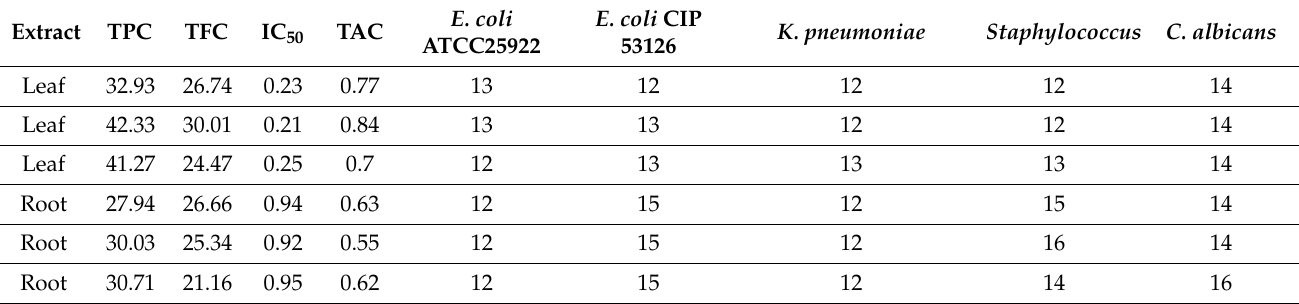
Table 2. The raw data of the analyses carried out on the C. humilis plant with three repetitions.